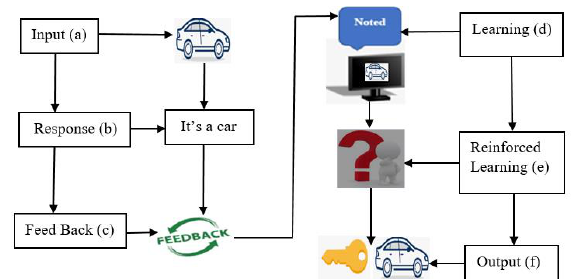
Figure 1. An evocative reinforcement learning progression